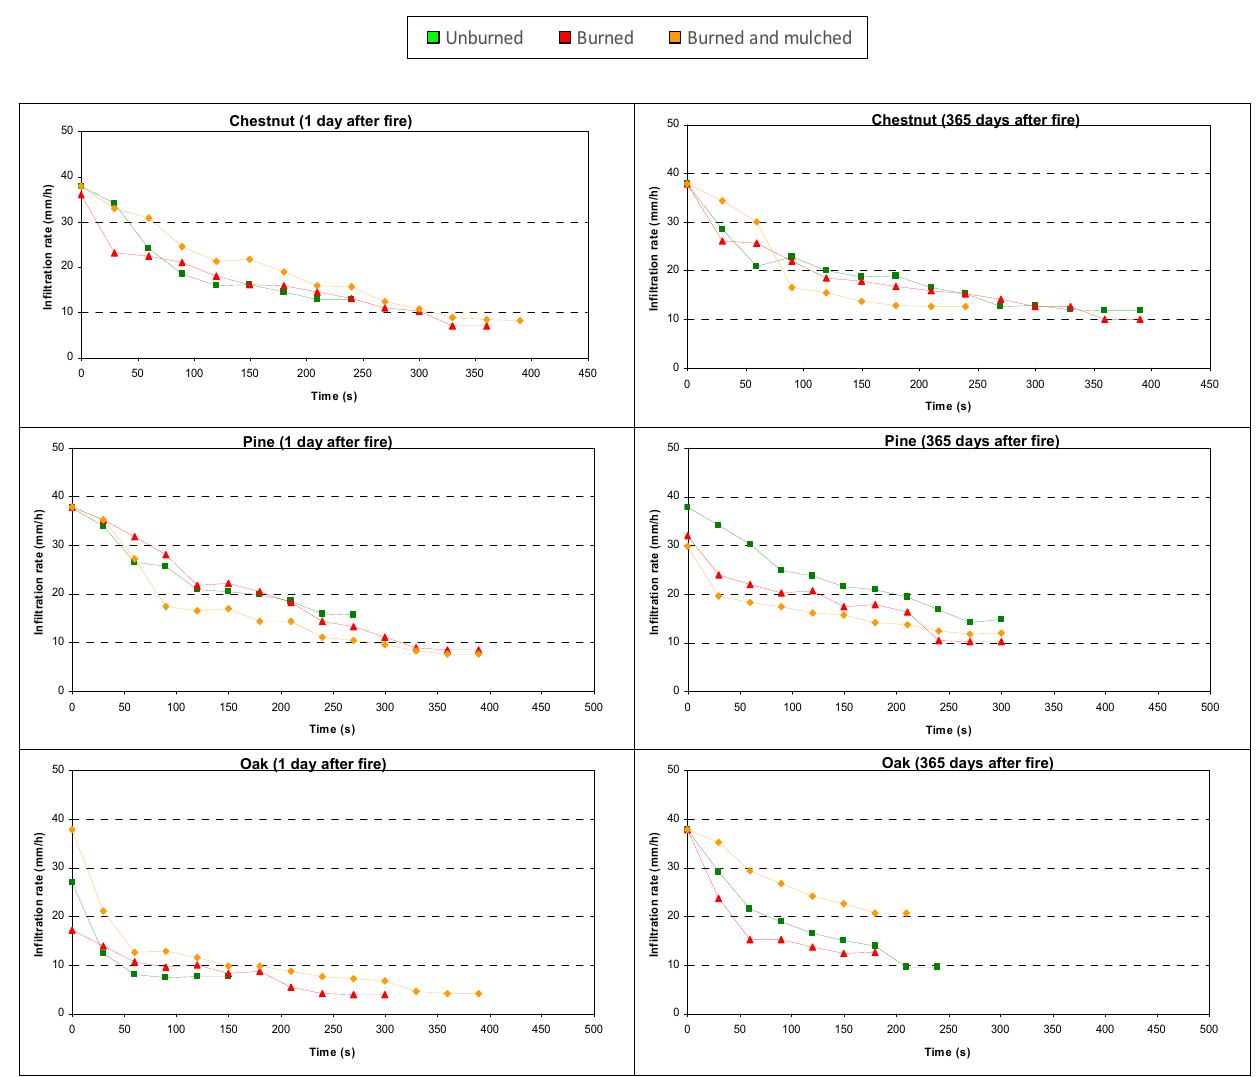
Figure 2. Infiltration curves measured using a portable rainfall simulator after prescribed fire and soil mulching with fern in the experimental site (Samo, Calabria, Southern Italy).